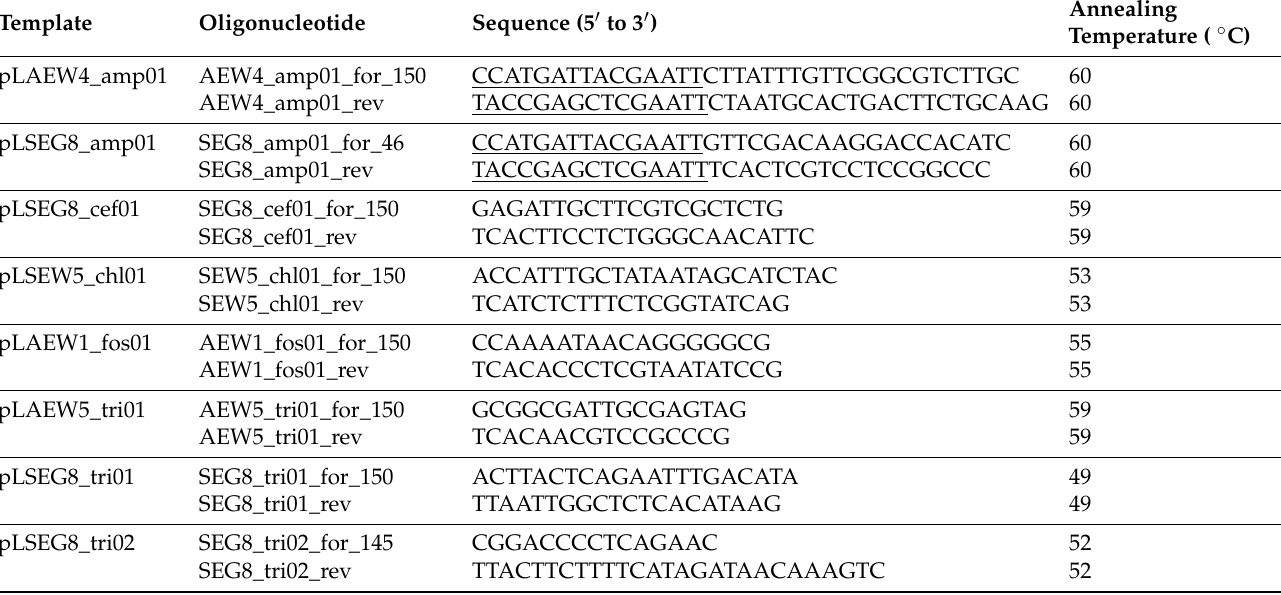
Table 5. Primer sets designed in this study and corresponding